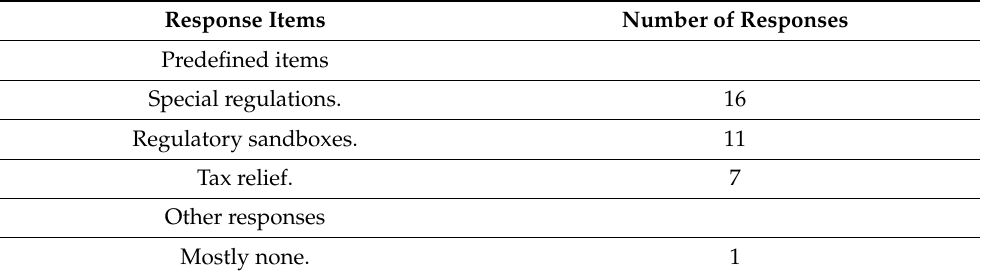
Table 3. Responses to the question how the Latvian state could contribute to the FinTech sector development (multiple responses